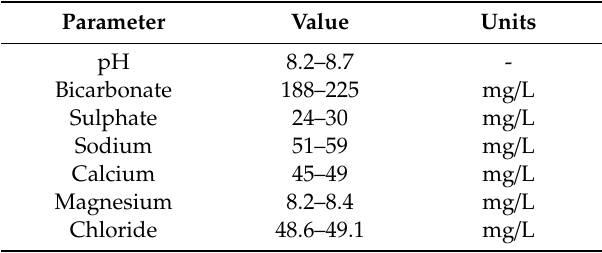
Table 2. Tap water